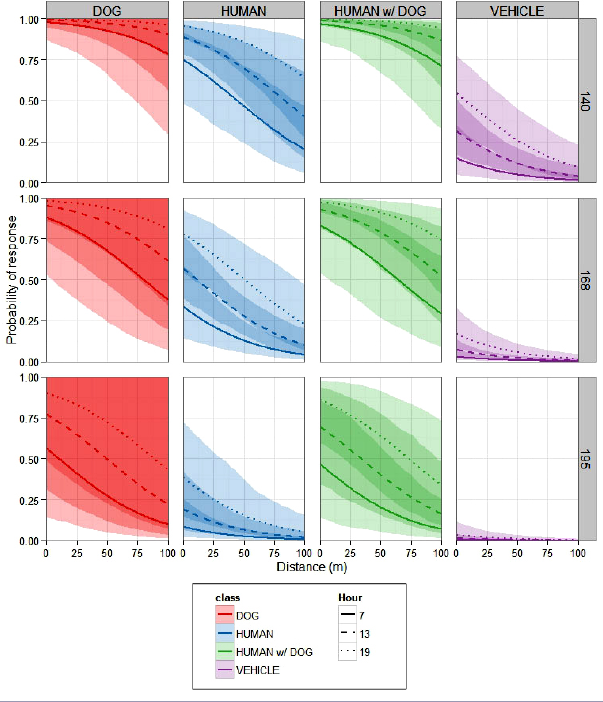
Fig. 2 . Predicted mean probability and 95% confidence intervals (shading) of a Piping Plover ( Charadrius melodus ) nest absence by distance in response to four classes of naturally occurring human-related stimuli by hour of day at 0700 (solid line), 1300 (dashed line), and 1900 (dotted line) at the beginning (top row; Julian day 140), middle (middle row, Julian day 168), and end (lower row, Julian day 195) of the nesting season. Darker areas of shading show areas where 95% confidence intervals overlap. The probability of flight initiation decreased over the course of the incubation period for all stimuli, but increased slightly over the course of a day. Higher probability of flight initiation is predicted for dog and human with dog compared to human and vehicle across the incubation